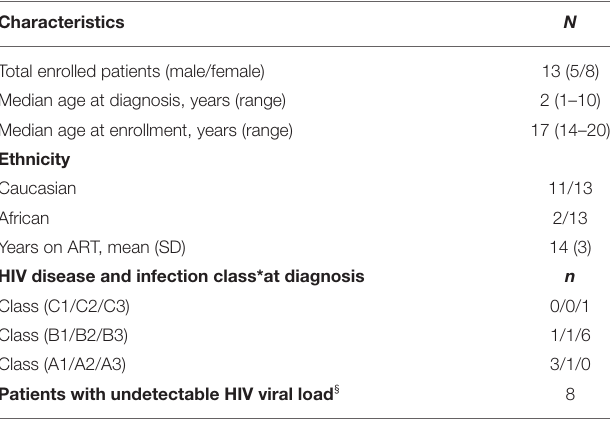
enrollment. Characteristics